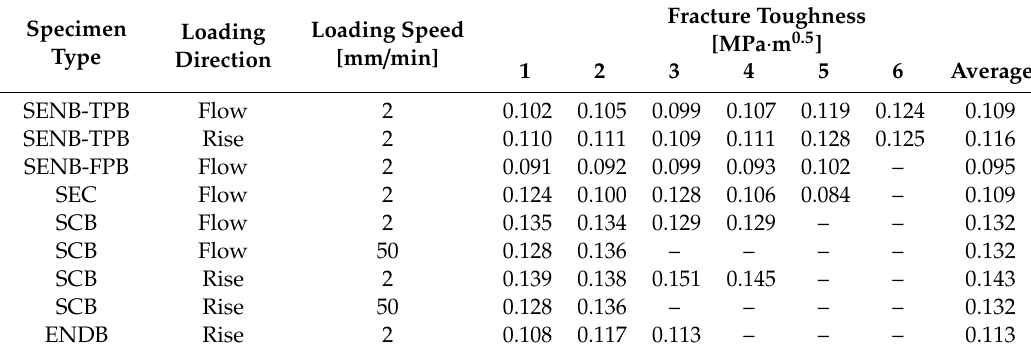
Table 3. Fracture toughness results for 145 kg / m 3 PUR foam density.